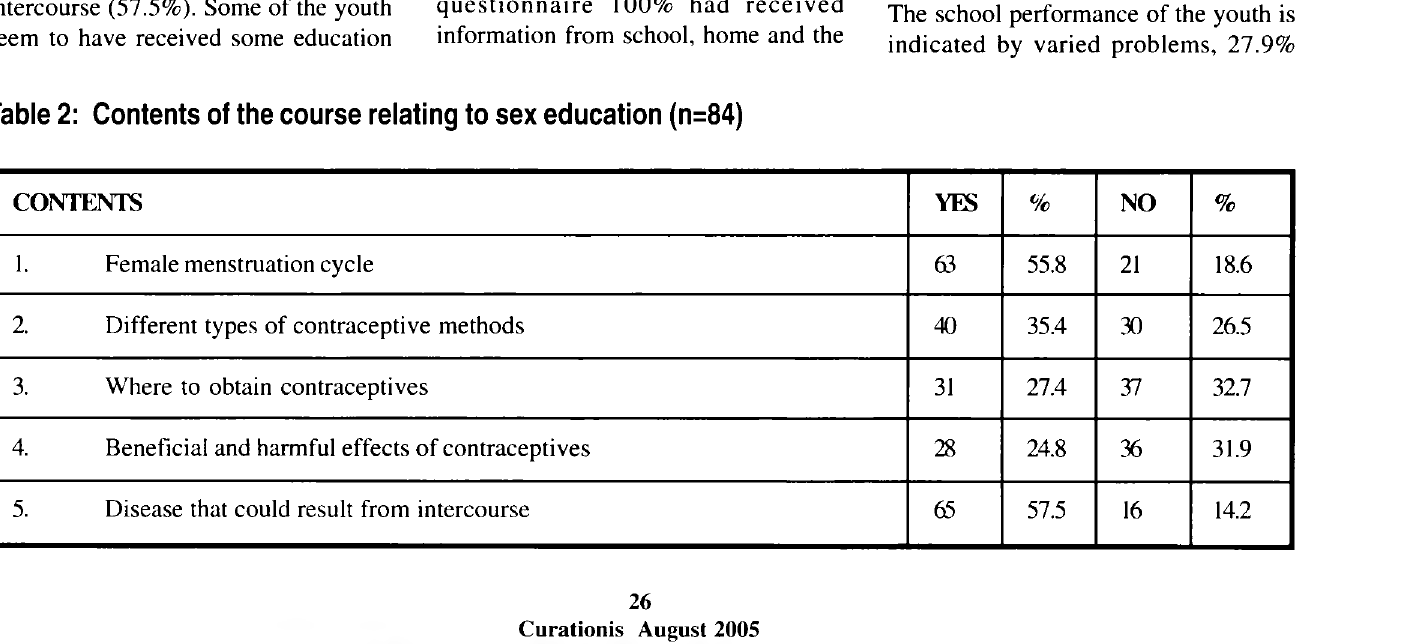
Table 2: Contents of the course relating to sex education